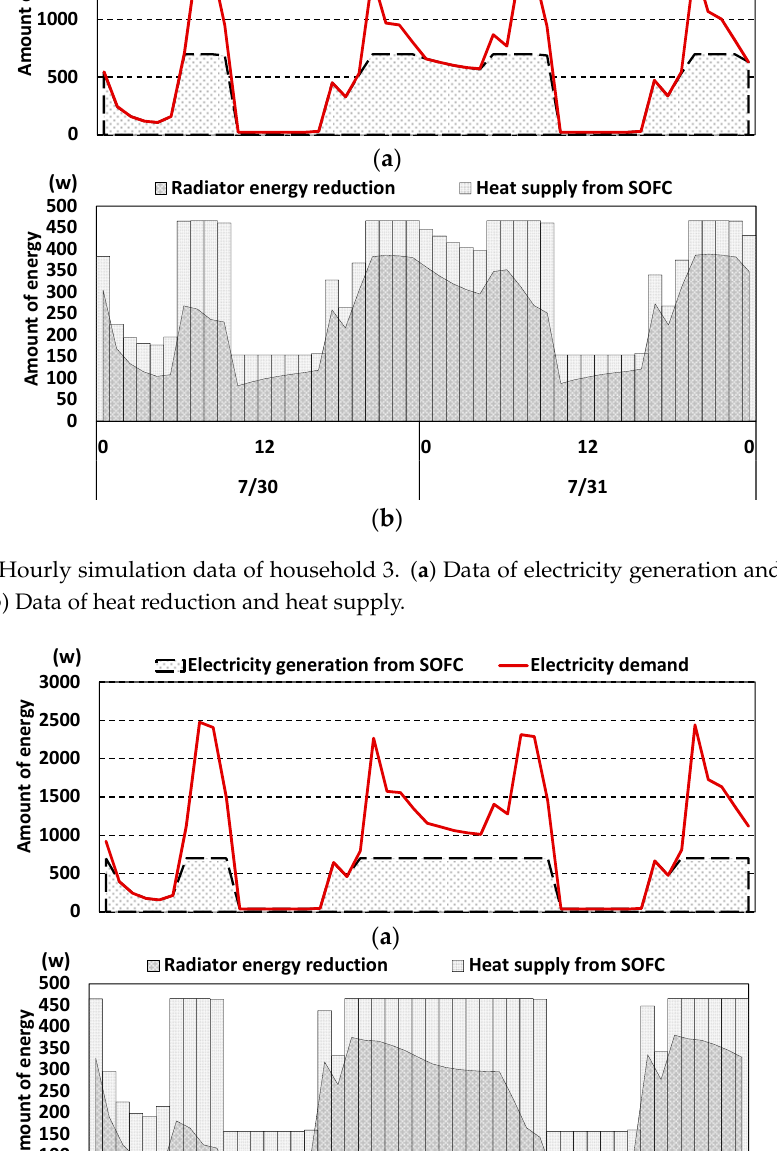
Figure 9. Hourly simulation data of household 2. ( a ) Data of electricity generation and electricity demand; ( b ) Data of heat reduction and heat supply.